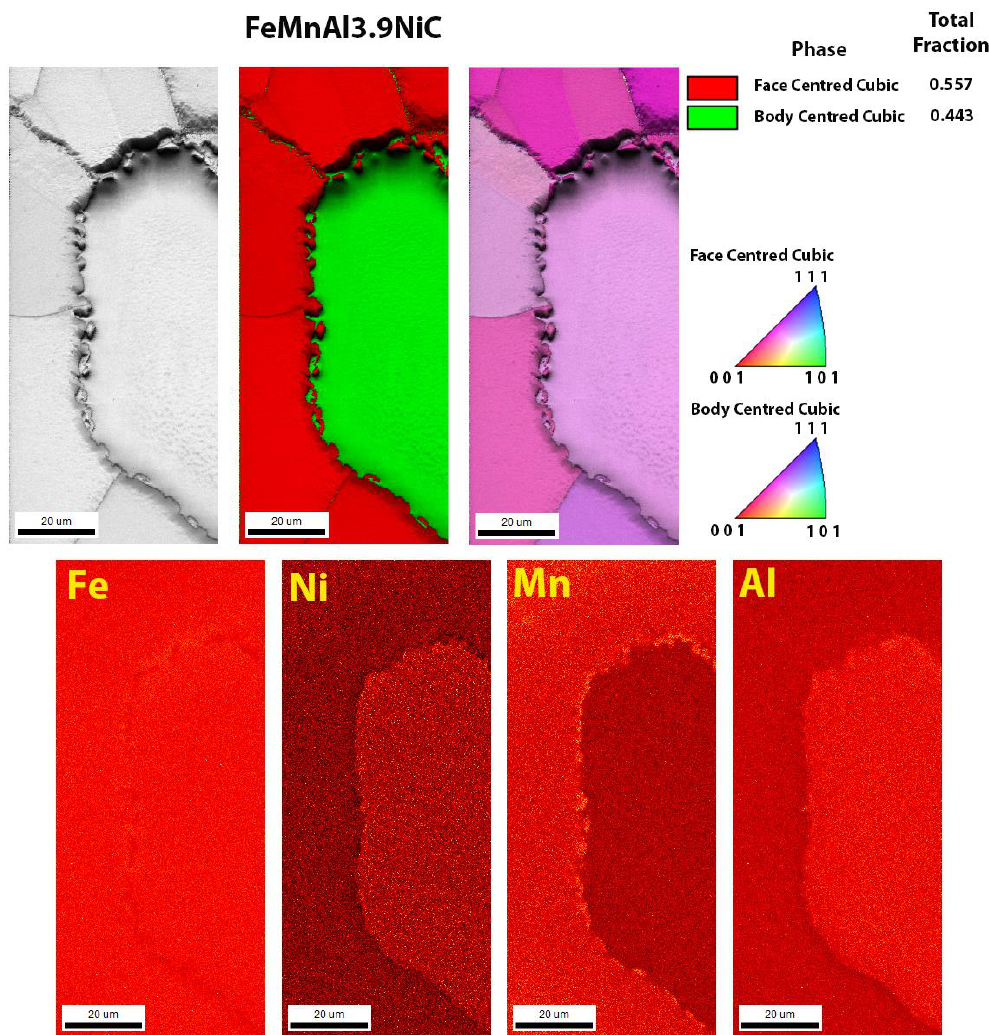
Figure 8. Electron backscattered diffraction analysis of a sample as-cast FeMnAl3.9NiC sample and SEM EDS (Energy- dispersive X-ray spectroscopy) elemental mapping of Fe, Ni, Mn, and Al.